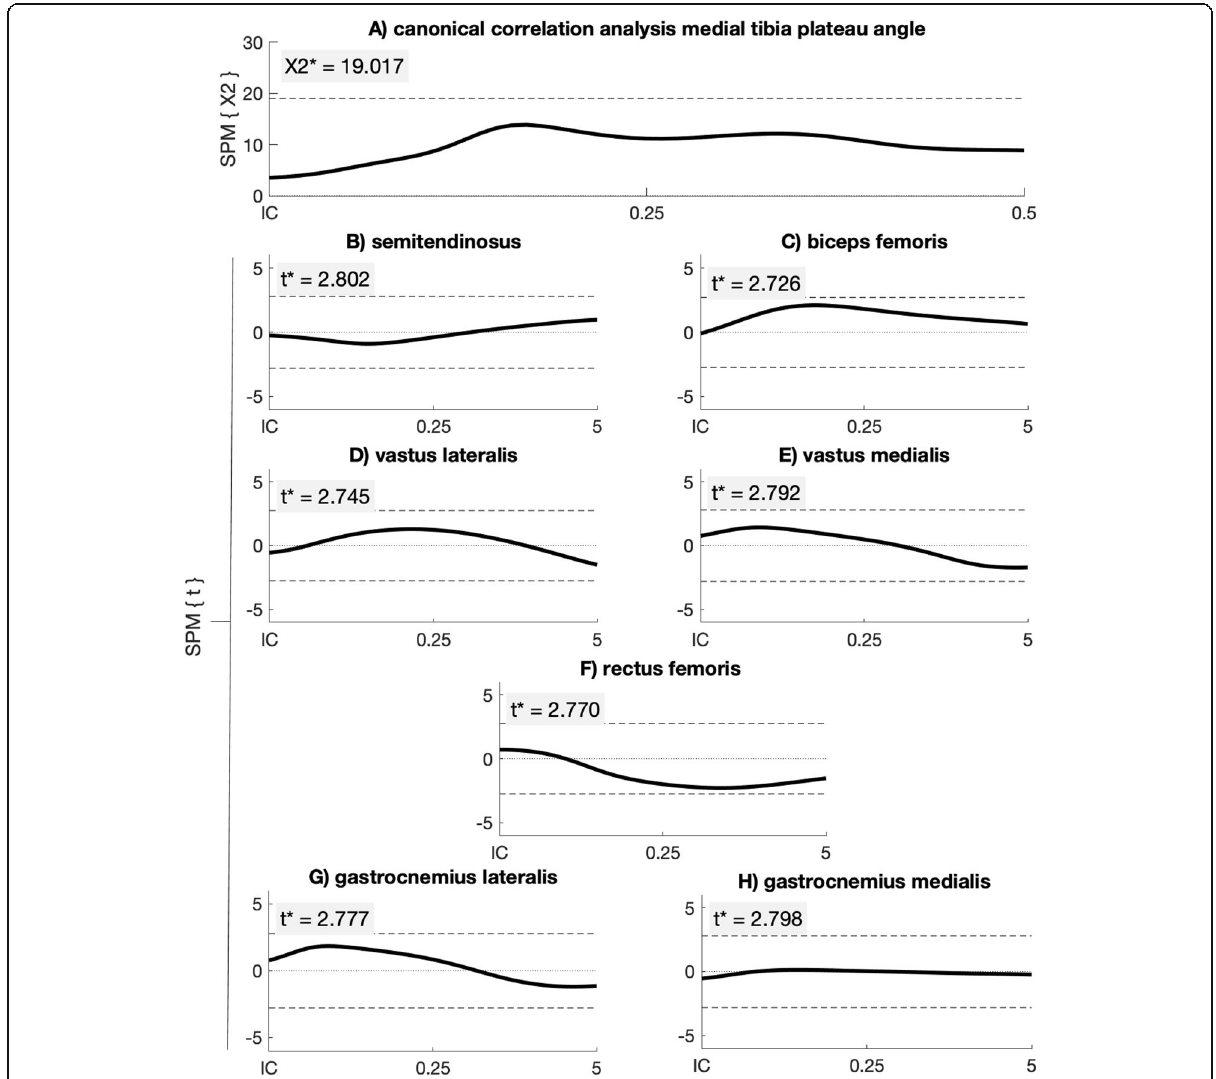
Fig. 5 SPM{X 2 } canonical correlation analysis between muscle activity and the MPTPA ( a ). Pos-hoc SPM{t} regression analysis between MPTPA and the medial hamstrings ( b ), biceps femoris ( c ), vastus lateralis ( d ), vastus medialis ( e ), rectus femoris ( f ), gastrocnemius lateralis ( g ) and gastrocnemius medialis ( h ) activation. X2* and t* are the significant boundaries of the